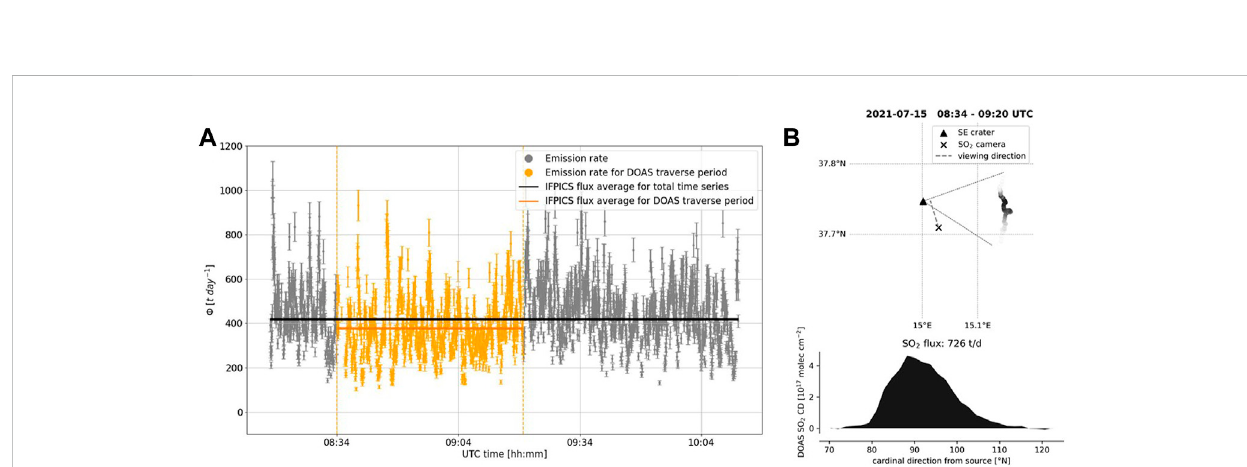
FIGURE 6 SO 2 fl uxmeasurementsfrom15thJuly2021(seeFigure5) (A) IFPICSSO 2 fl uxmeasuredinanapproximatedistanceof5.3 kmtothecraterareaofMt Etna between 08:05 and 10:20 UTC. The orange part of the IFPICS data marks the time period of a DOAS car traverse measurement shown in panel (B) . Thehorizontallinesmarktheaverage fl uxforthecompletetimeseries(black,(418±138)tday − 1 )andforthetraversetime[orange,(378±129)t day − 1 )]. (B) DOAScartraversemeasurementofSO 2 fl uxbetween08:34and09:20UTC.Theupperpanelshowsthelocationanddirectionoftheplumeandthe viewing direction of the SO 2 camera. The lower panel shows the SO 2 CD during the plume